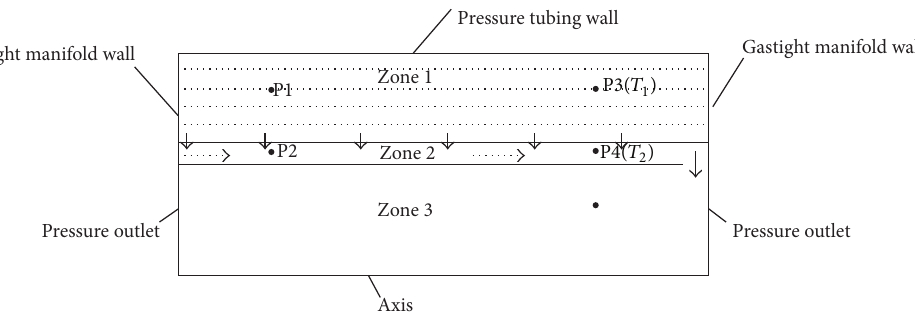
Figure 2: Computational